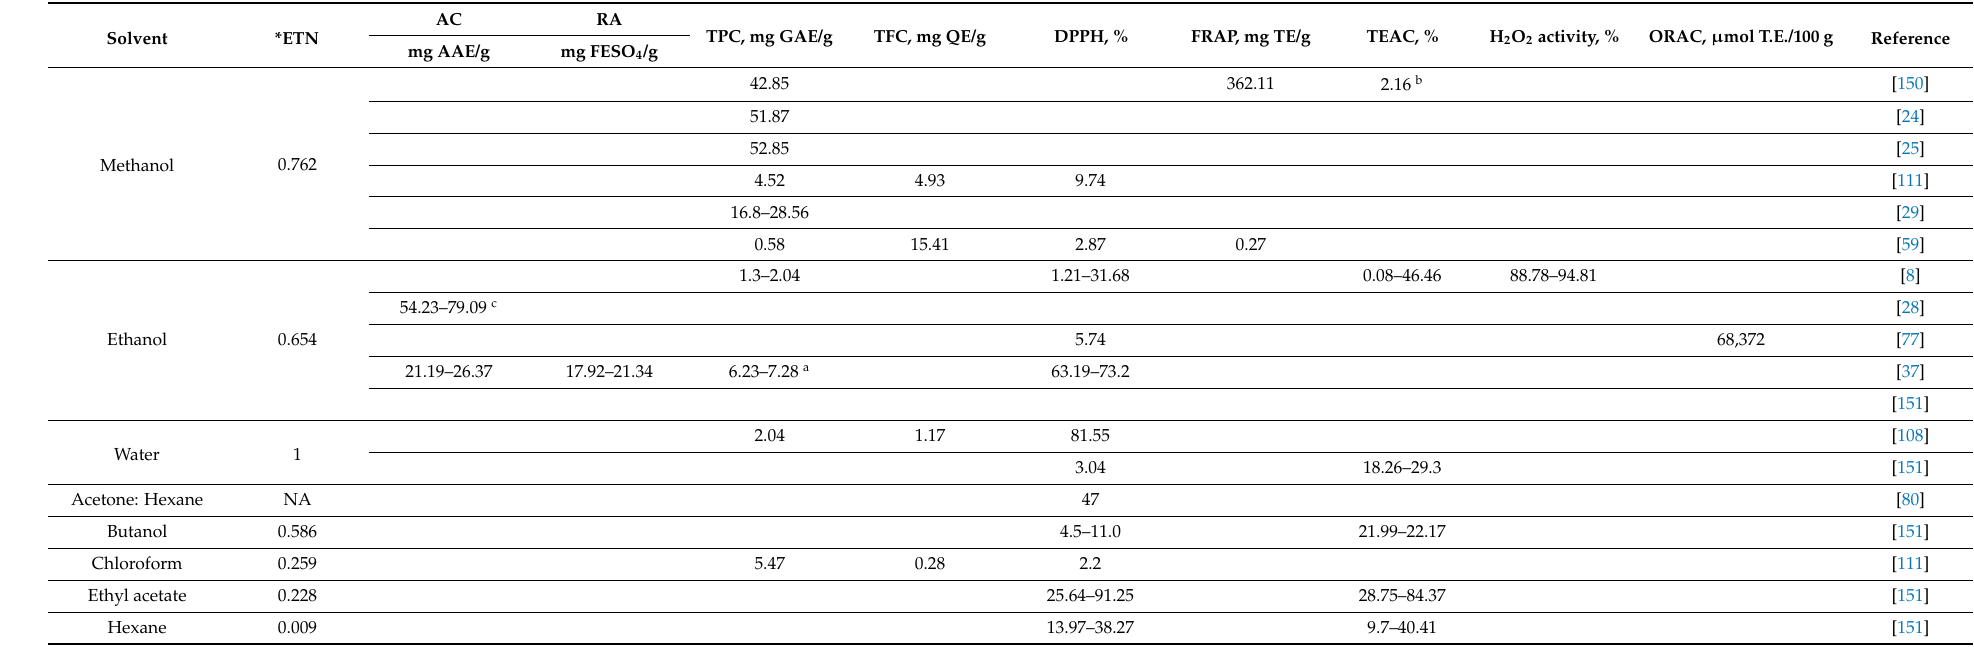
Table 9. Antioxidant activities in Caulerpa lentillifera